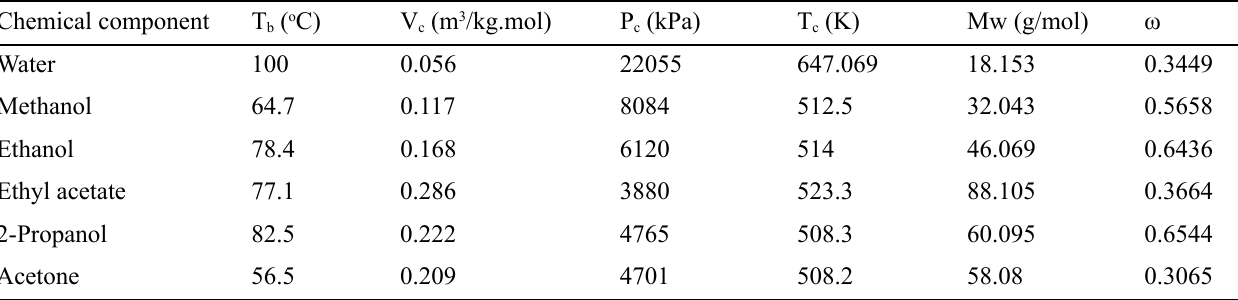
Table 2. Summarization of the boiling point and critical important constants of pure liquids.